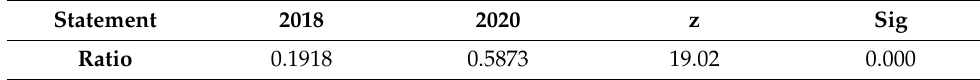
Table 14. Test Results of the difference between two